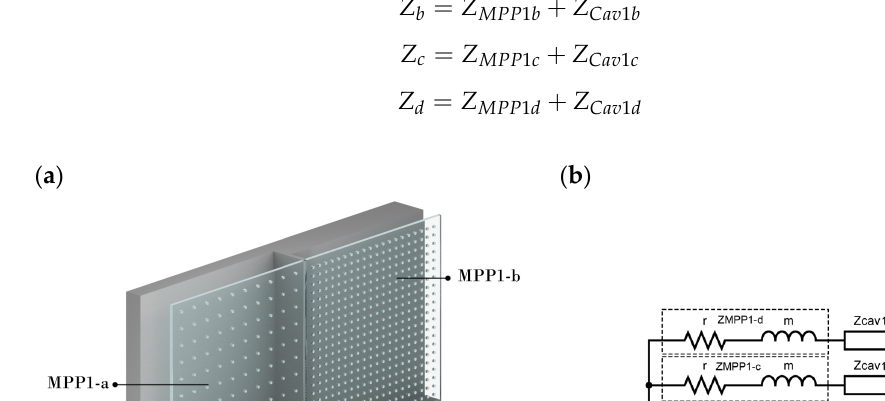
Table 1. Parameters of four parallel-arranged MPPs.